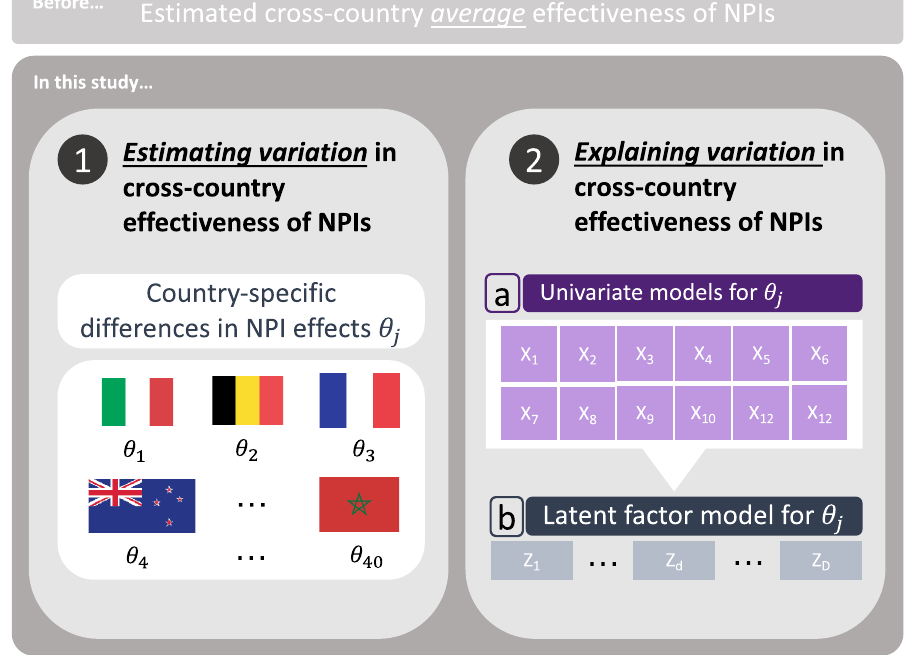
Figure 1. Visual summary of the two-step analysis for estimating and explaining variation in cross-country effectiveness of NPIs. Step 1 (cid:31) : Estimating variation in cross-country effects of NPIs θ 1 , . . . , θ 40 . Step 2 (cid:31) : Explaining variation in θ j through 12 country characteristics X 1 , . . . , X 12 . Association between characteristics and θ j is estimated as follows: a by linking θ j separately to each country characteristic, and b by linking θ j to latent factors Z 1 , . . . , Z D , which are determined with a latent factor